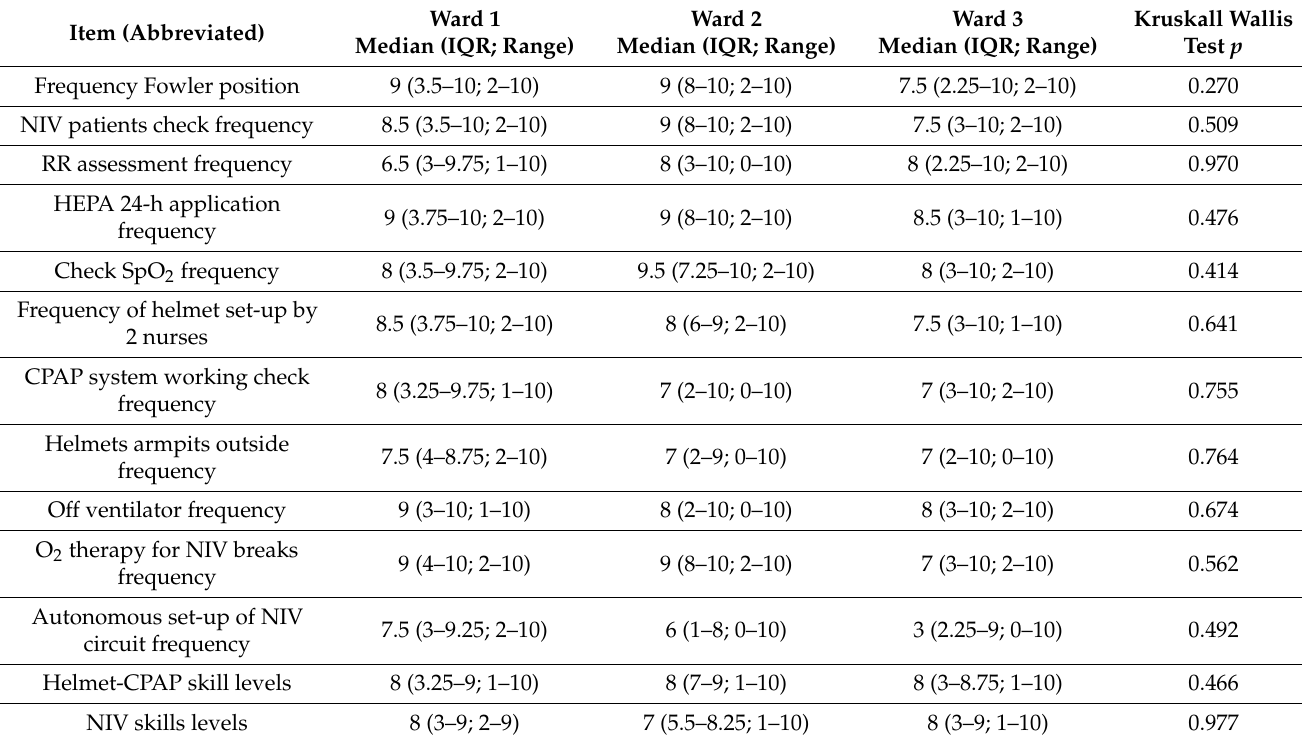
Table 3. Frequency of practicing the acquired skills after the training on the job by wards 1, 2, and 3 (59